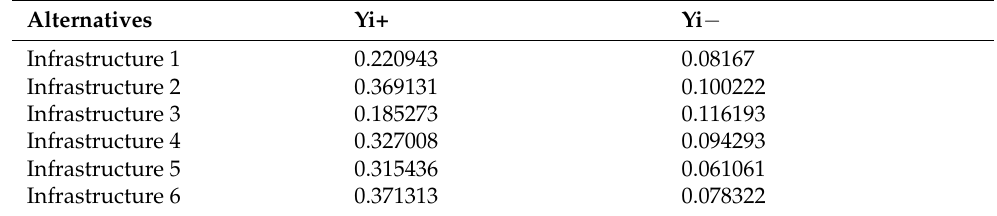
Table 8. Beneficial and Non-beneficial Features.